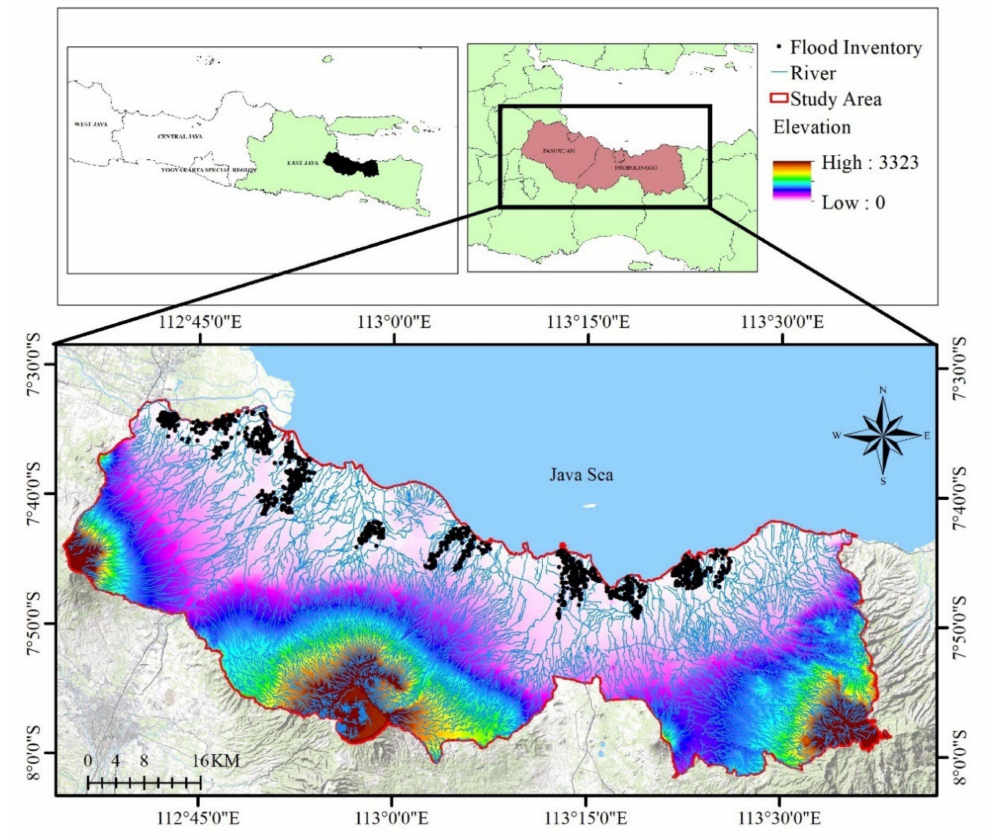
Figure 1. Study area